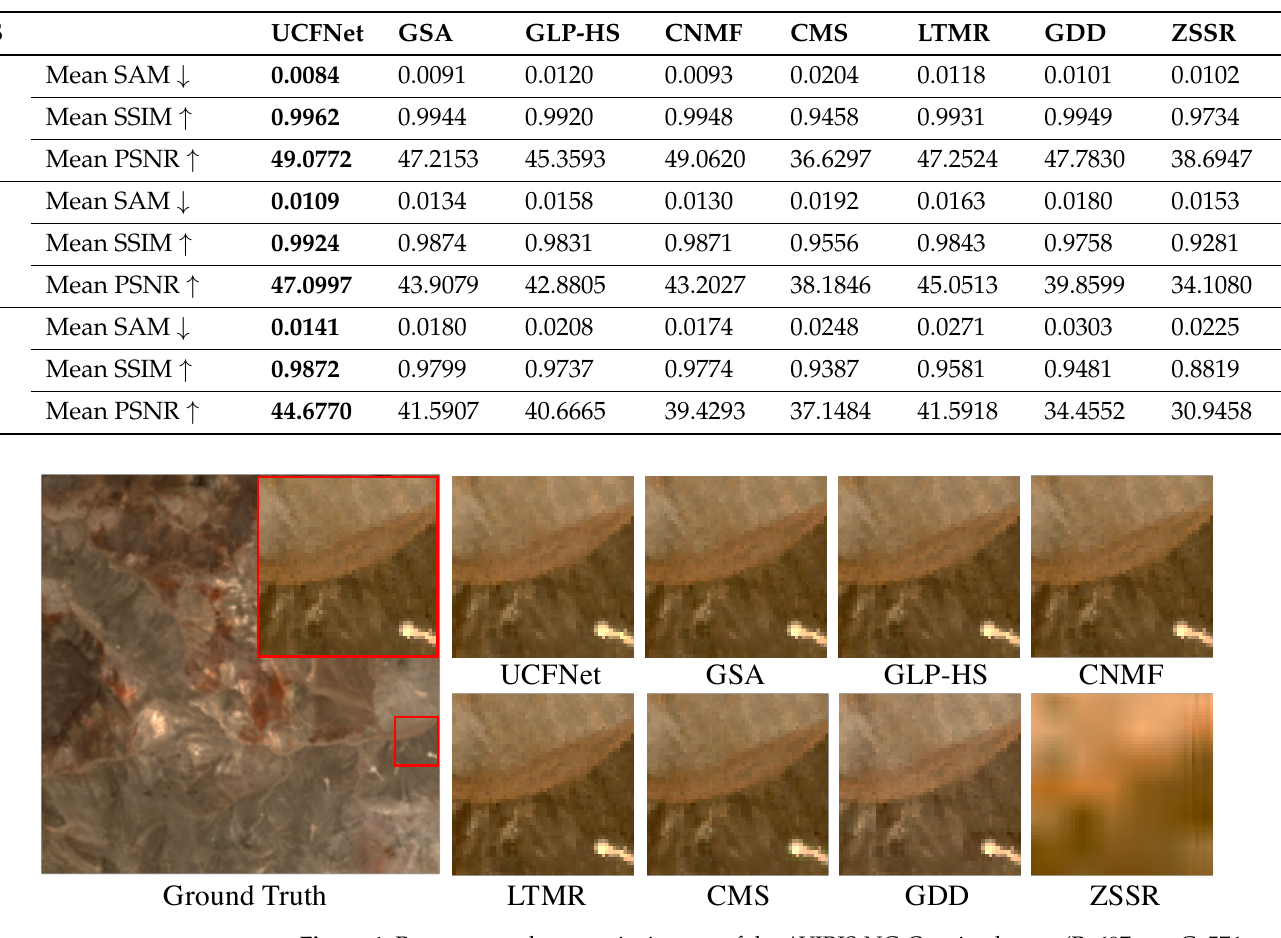
Figure 4. Reconstructed composite images of the AVIRIS-NG-Cuprite dataset (R: 697 nm, G: 576 nm, B: 492 nm) with a scaling factor of